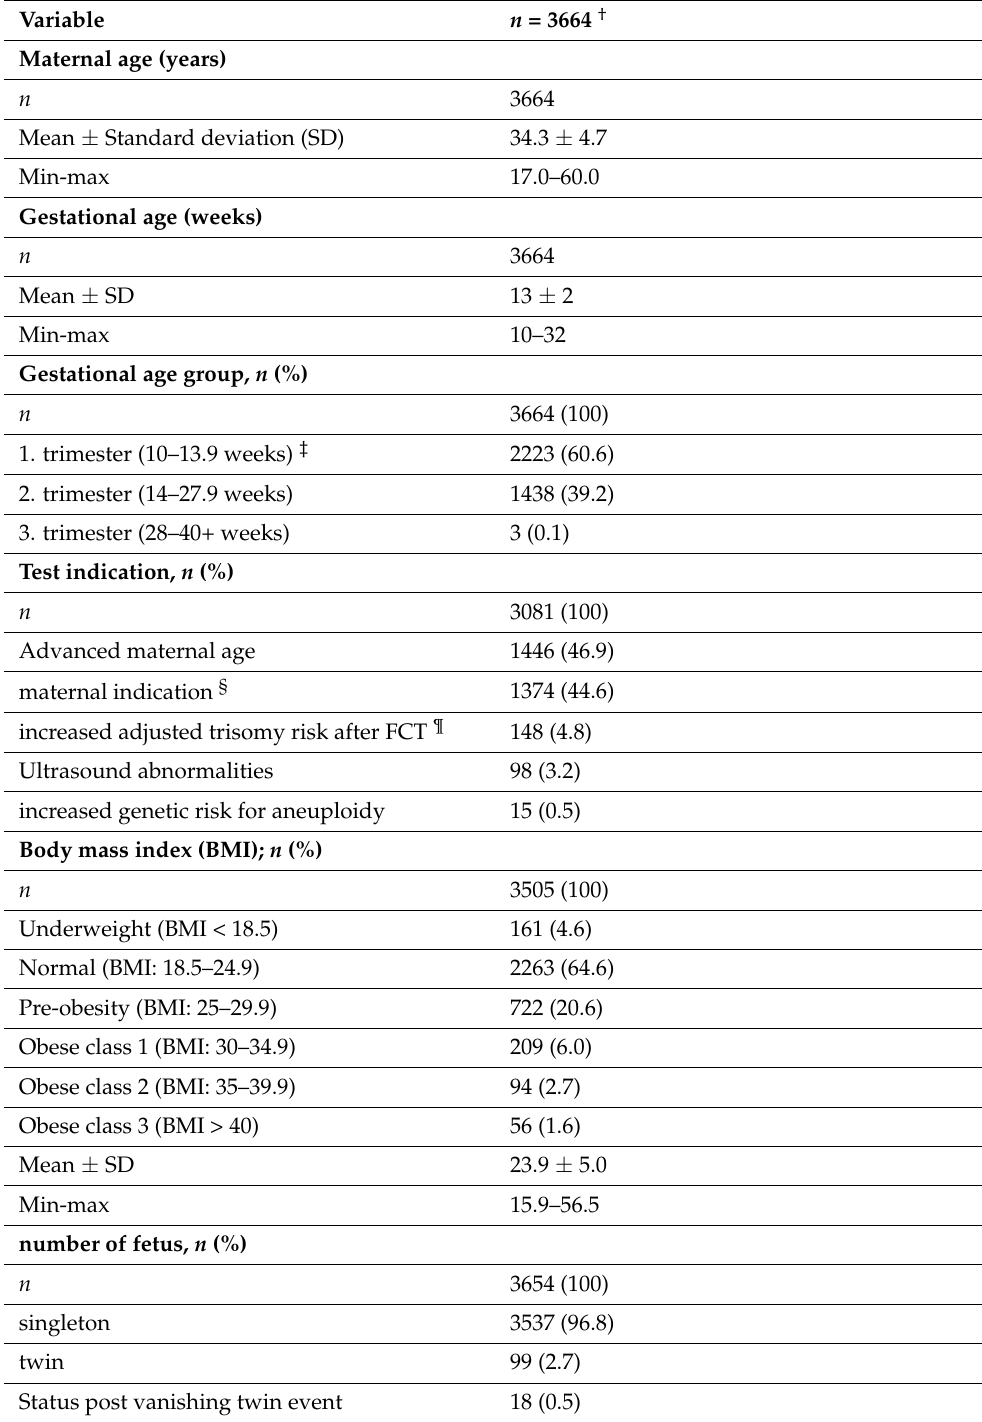
Table 1. Patient demographics of the study